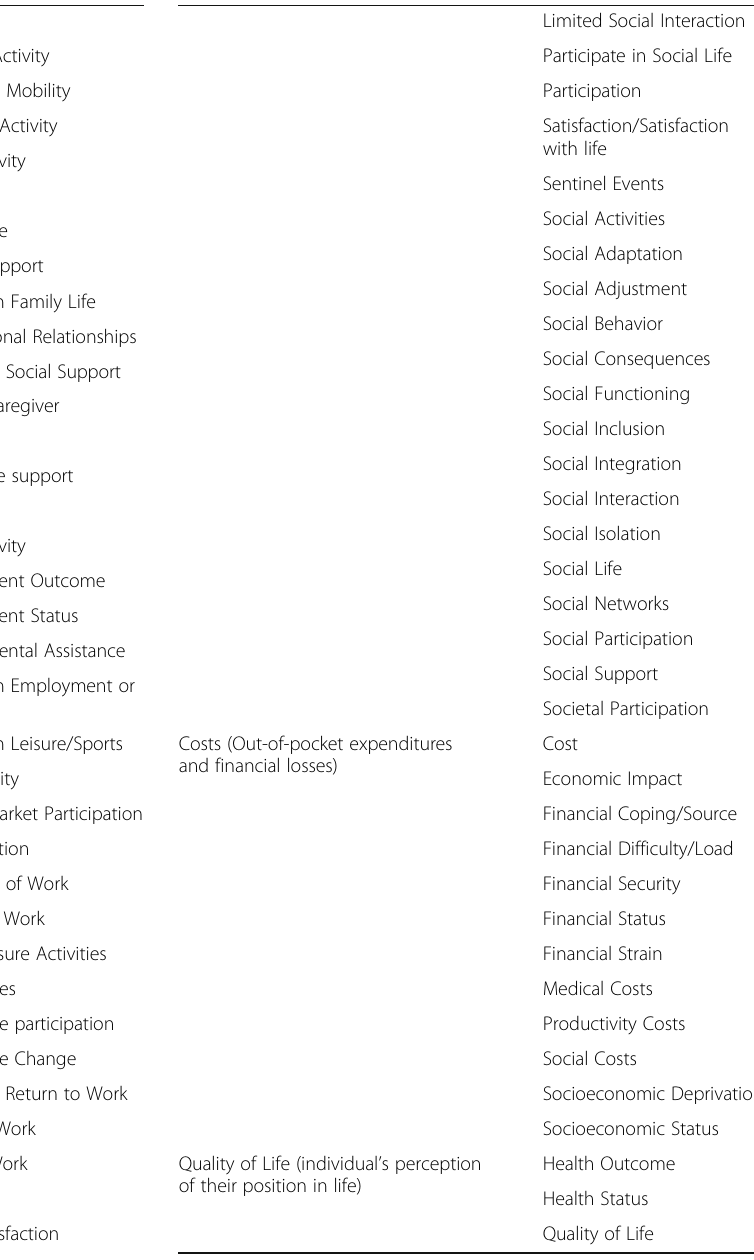
Table 3 Classification of Reported Outcomes into Domains based on WHODAS 2.0